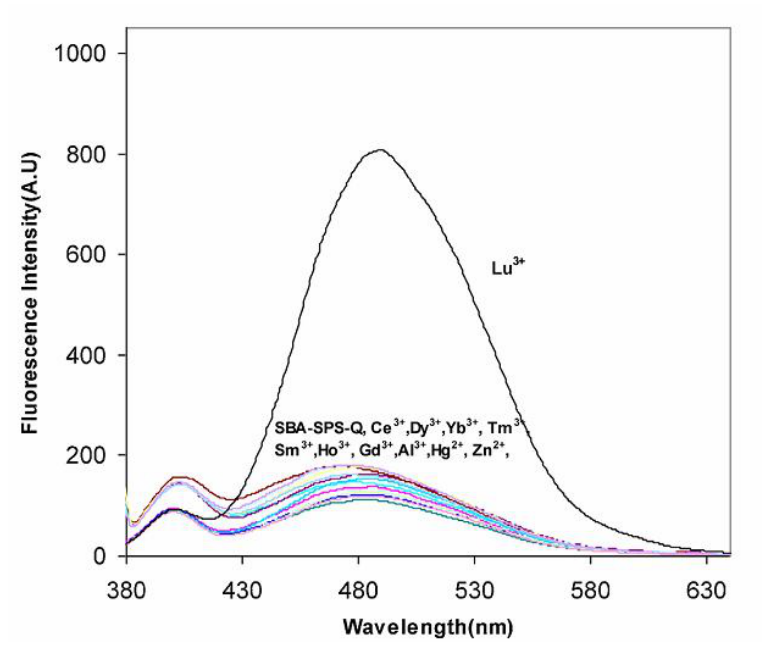
Fig. 7. Fluorescence emission spectra of SBA-SPS-Q suspended in an aqueous solution in the presence of different metal ions [34].